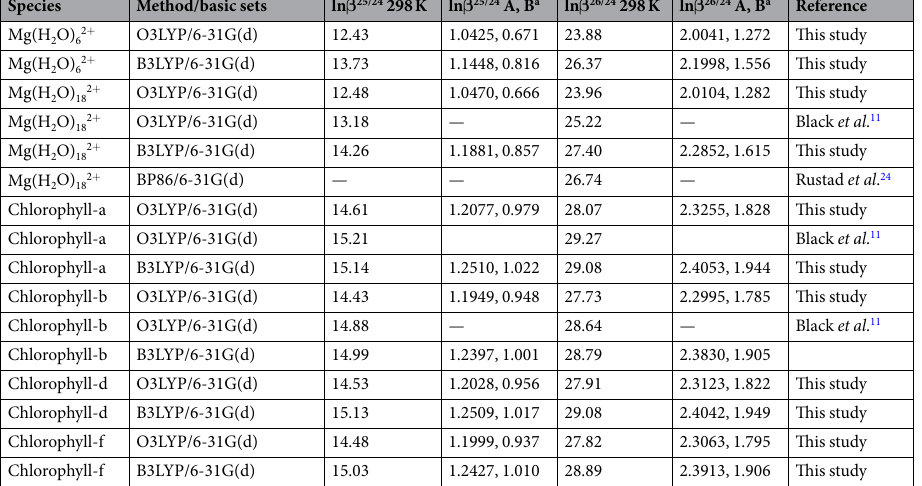
Table 2. Logarithm of the reduced partition function, ln β (‰), for the pair 26 Mg- 24 Mg and 25 Mg- 24 Mg of